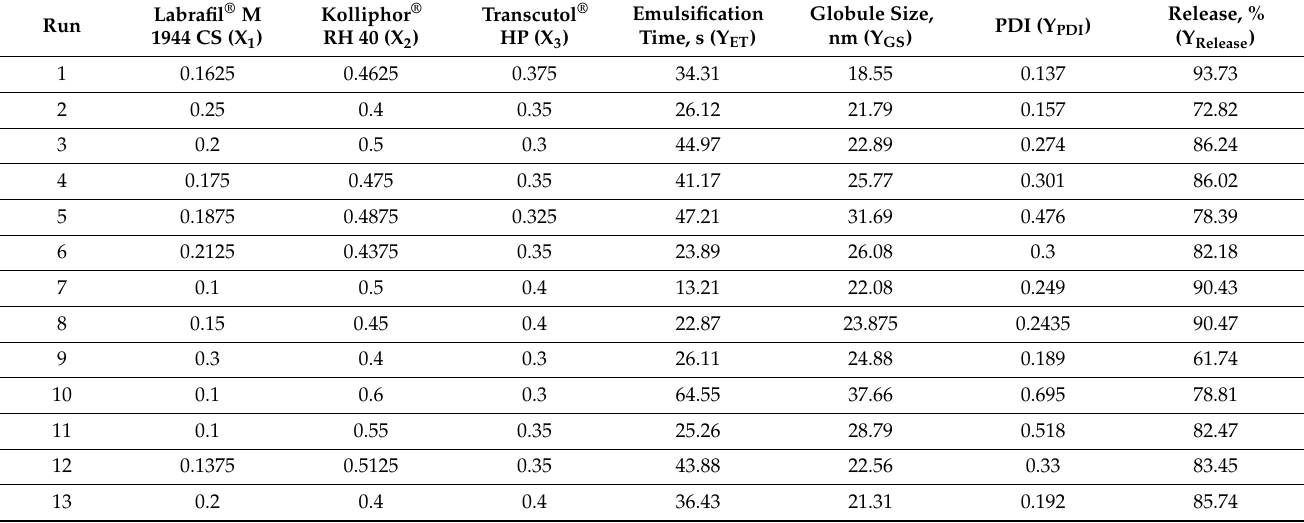
Table 3. Mixer design comprising CMAs as dependable variables and CQAs as independent